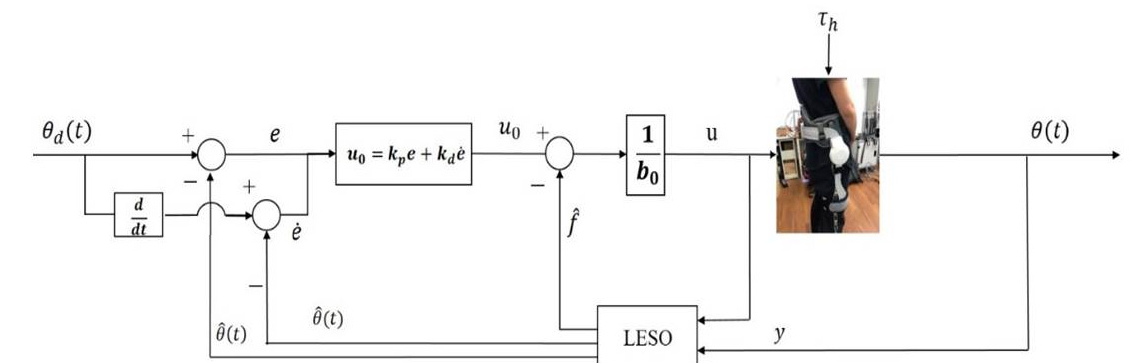
Figure 4. Control structure of LADRC.